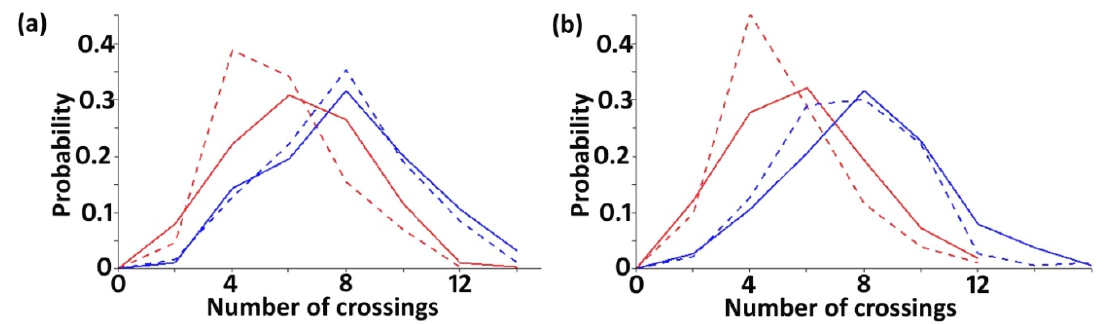
Figure 6. Probability distribution: ( a ) Number of crossings at 1/12 of the maximal normalized power. ( b ) Number of crossings at 1/16 of the maximal normalized power. Red full and dashed lines are sand site1 and site 2, respectively, while blue full and dashed lines are sandstone site 3 and site 4, respectively.